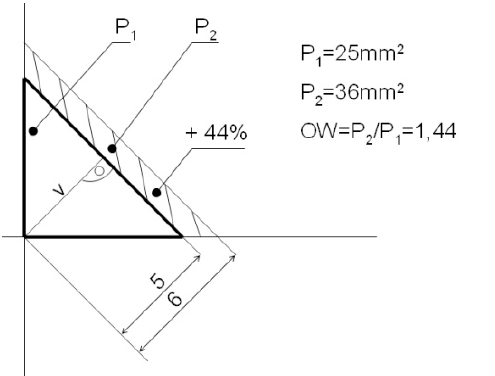
Fig. 2a. Fillet-deposited weld